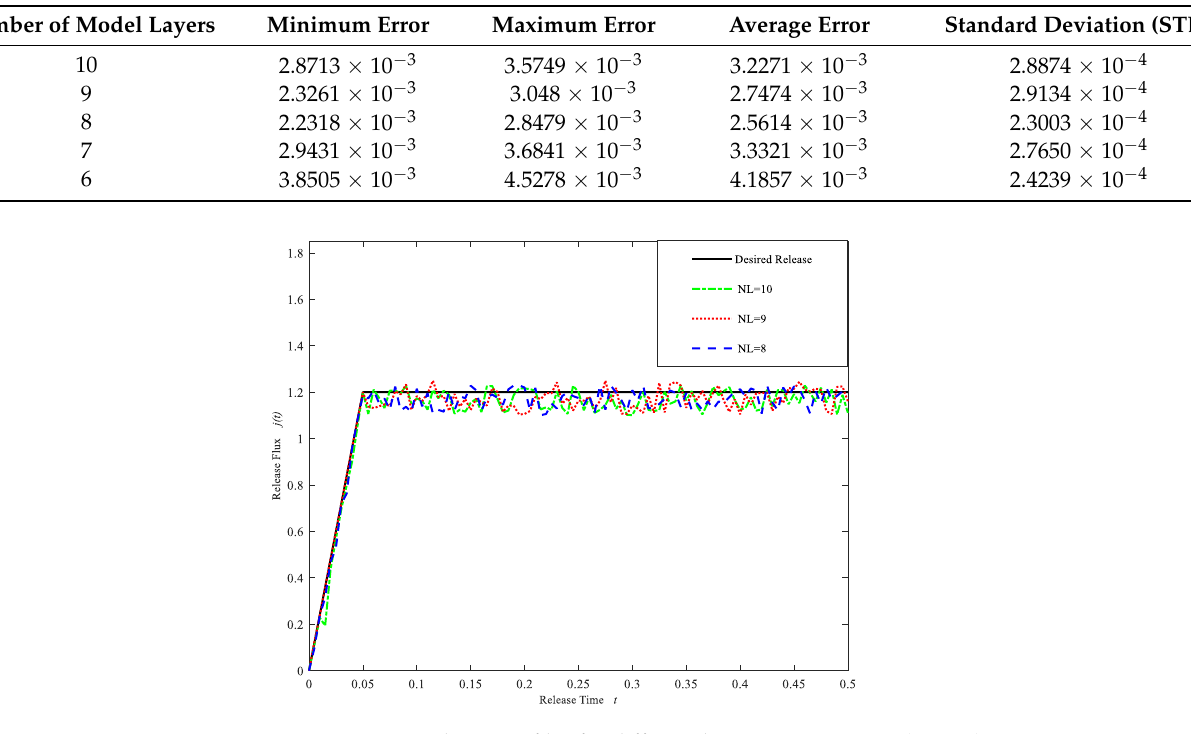
Figure 9. Drug Release profiles for different layers NL = 8, 9, 10. (Case 3). Table 12. Initial drug concentration and diffusion coefficient at each layer of the drug-controlled release model for NL = 8 (Case